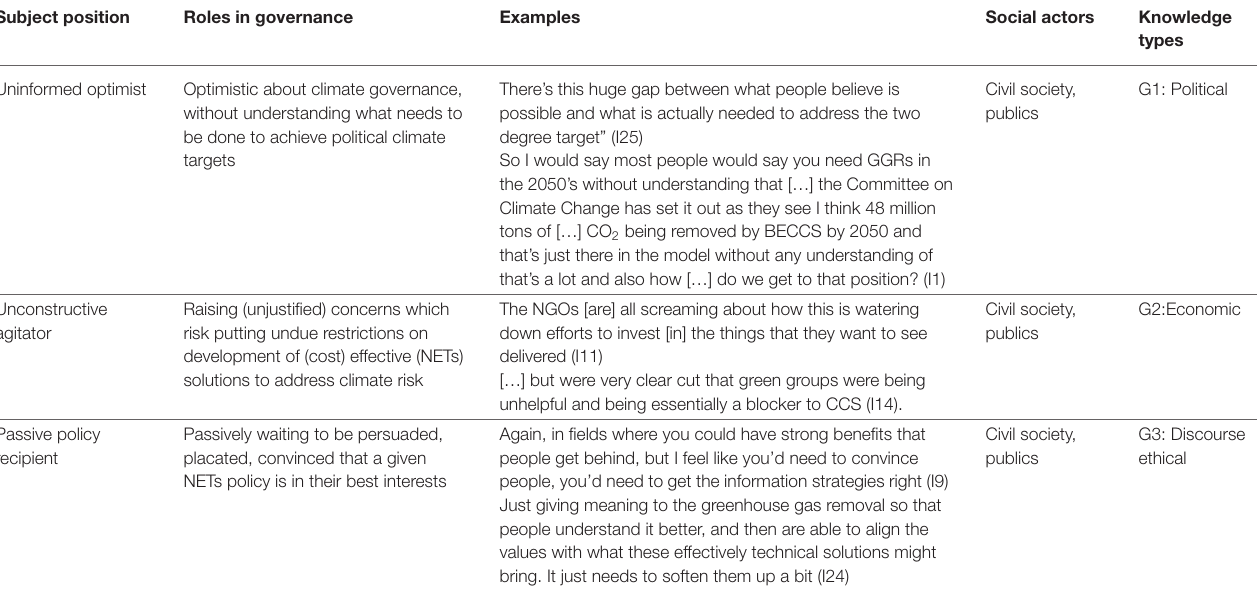
TABLE 5 | Subject positions (passive) offered by discusive